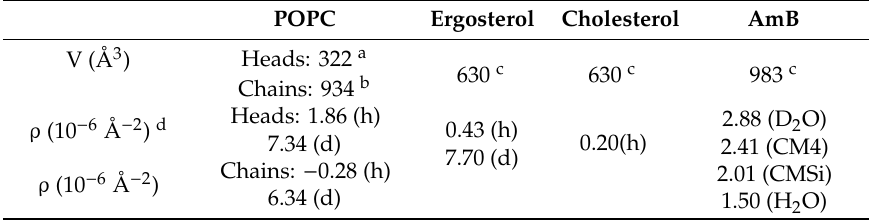
Table 1. Neutron scattering length densities and molecular volumes used in this